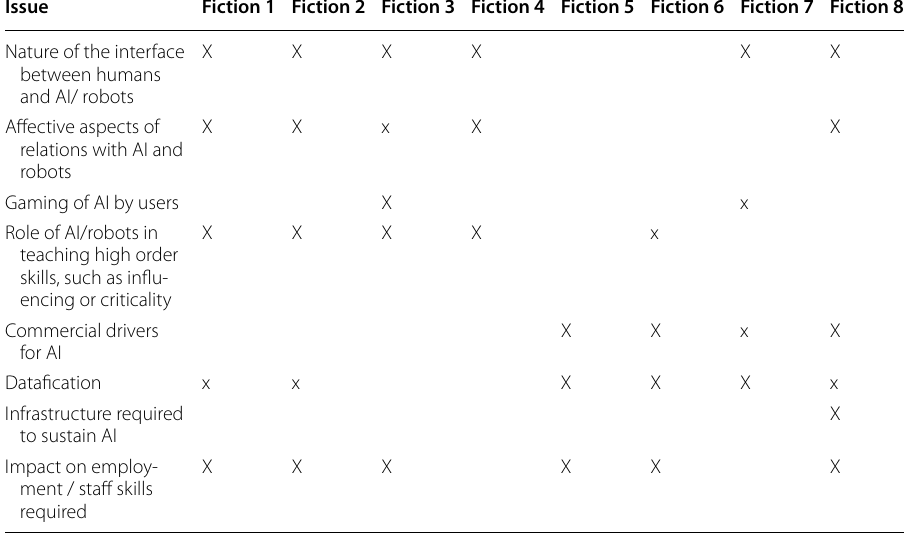
Table 2 Issues raised in the fictions